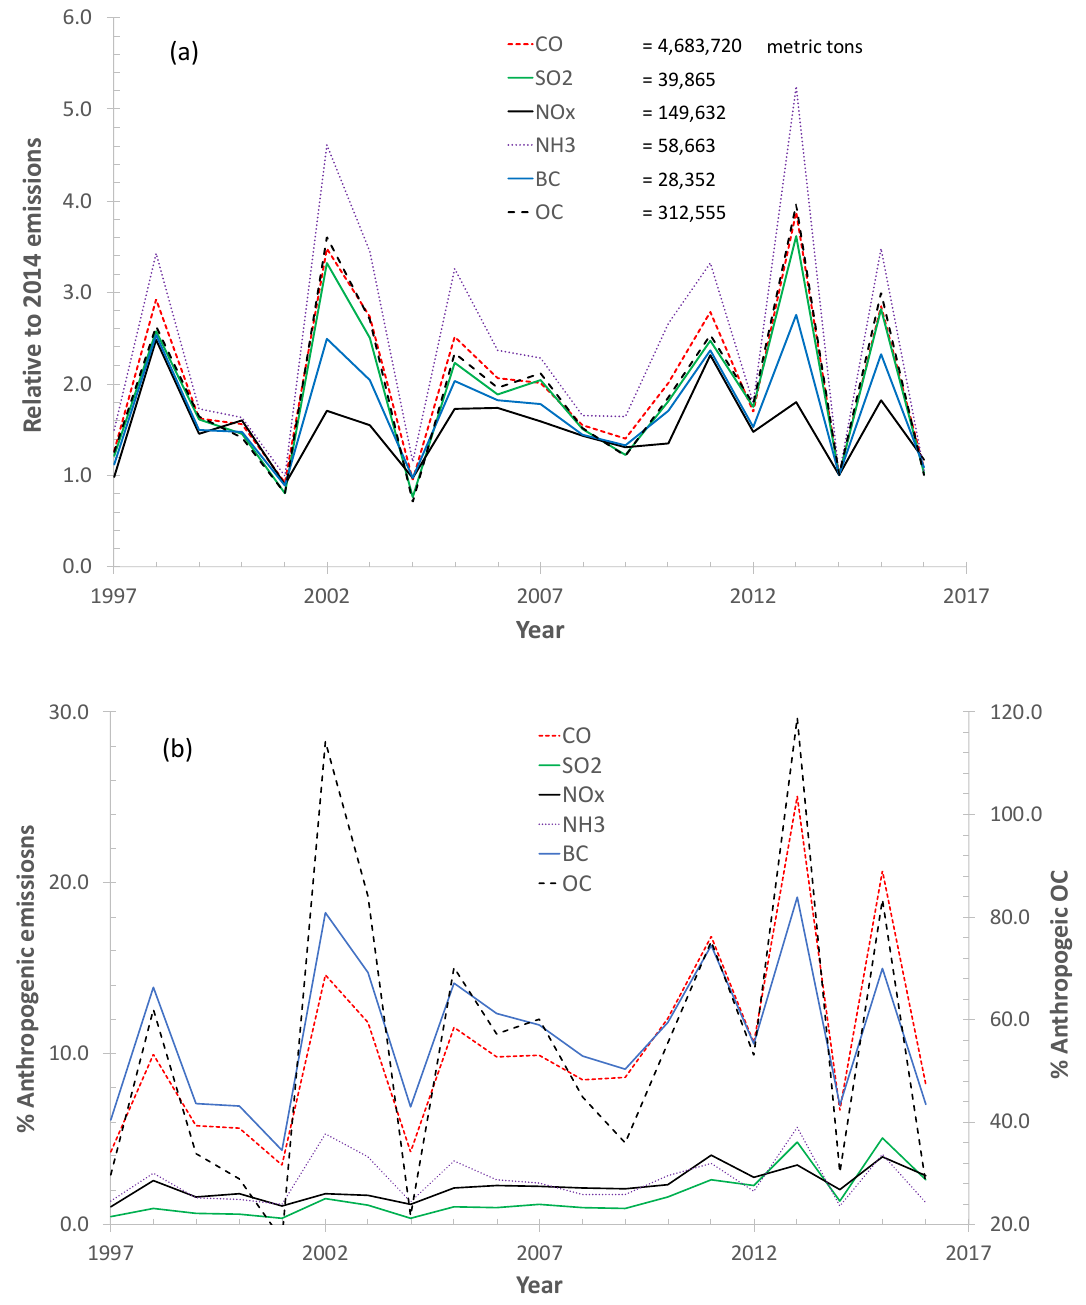
Figure 1. ( a ) Evolution of fire emissions from 1997 to 2016 normalized to the 2014 levels. Numbers are 2014 emissions in metric tons for each species. ( b ) Variations in ratios of fire to anthropogenic emissions from 1997 to 2016 for selected species, right y-axis is for OC